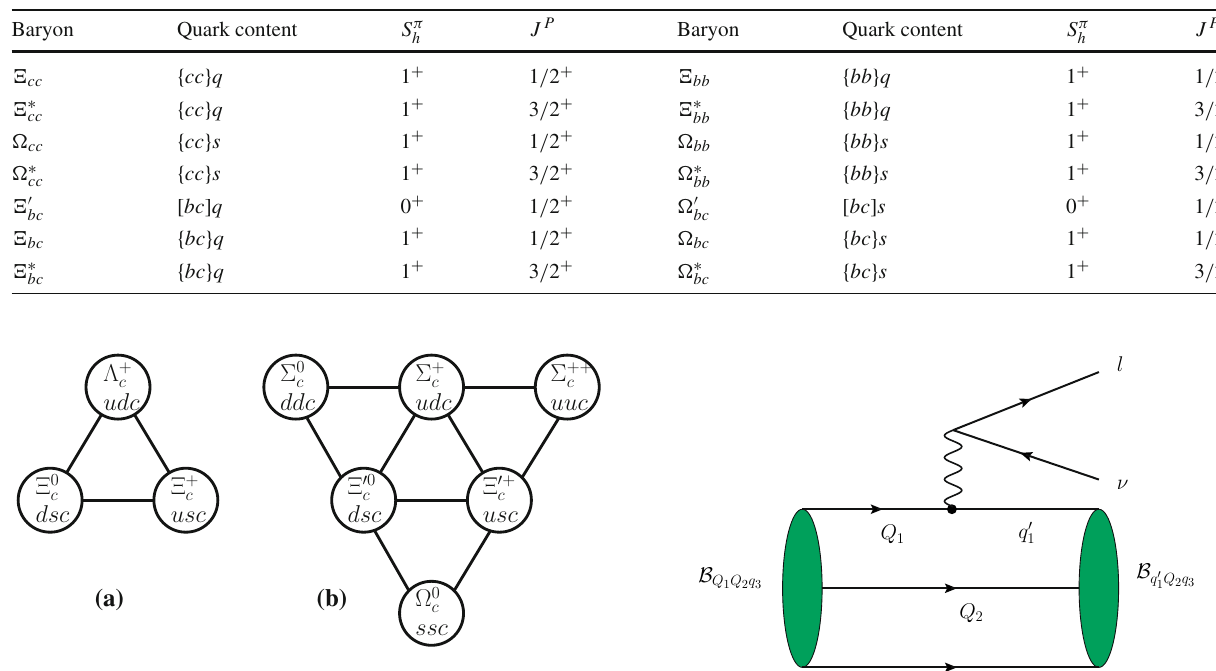
Table 1 Quantum numbers and quark content for the lowest-lying doubly-heavy baryons. S π quarks. The light quark q corresponds to the u , d quark